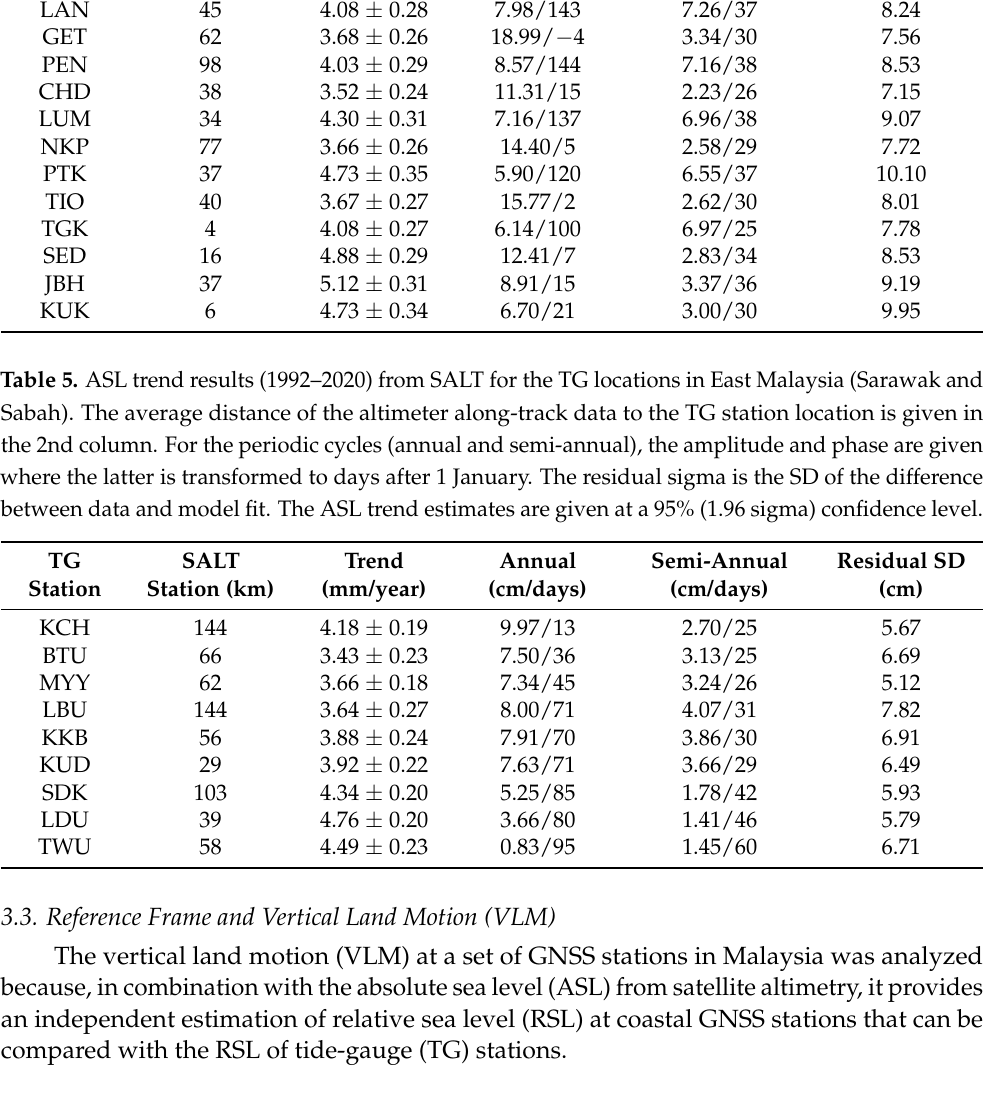
Table 4. ASL trend results (1992–2020) from SALT for the TG locations in Peninsular Malaysia. The average distance of the altimeter along-track data to the TG station location is given in the 2nd column. For the periodic cycles (annual and semi-annual), the amplitude and phase are given where the latter is transformed to days after 1 January. The residual sigma is the SD of the difference between data and model fit. The ASL trend estimates are given at a 95% (1.96 sigma) confidence level. TG SALT Station